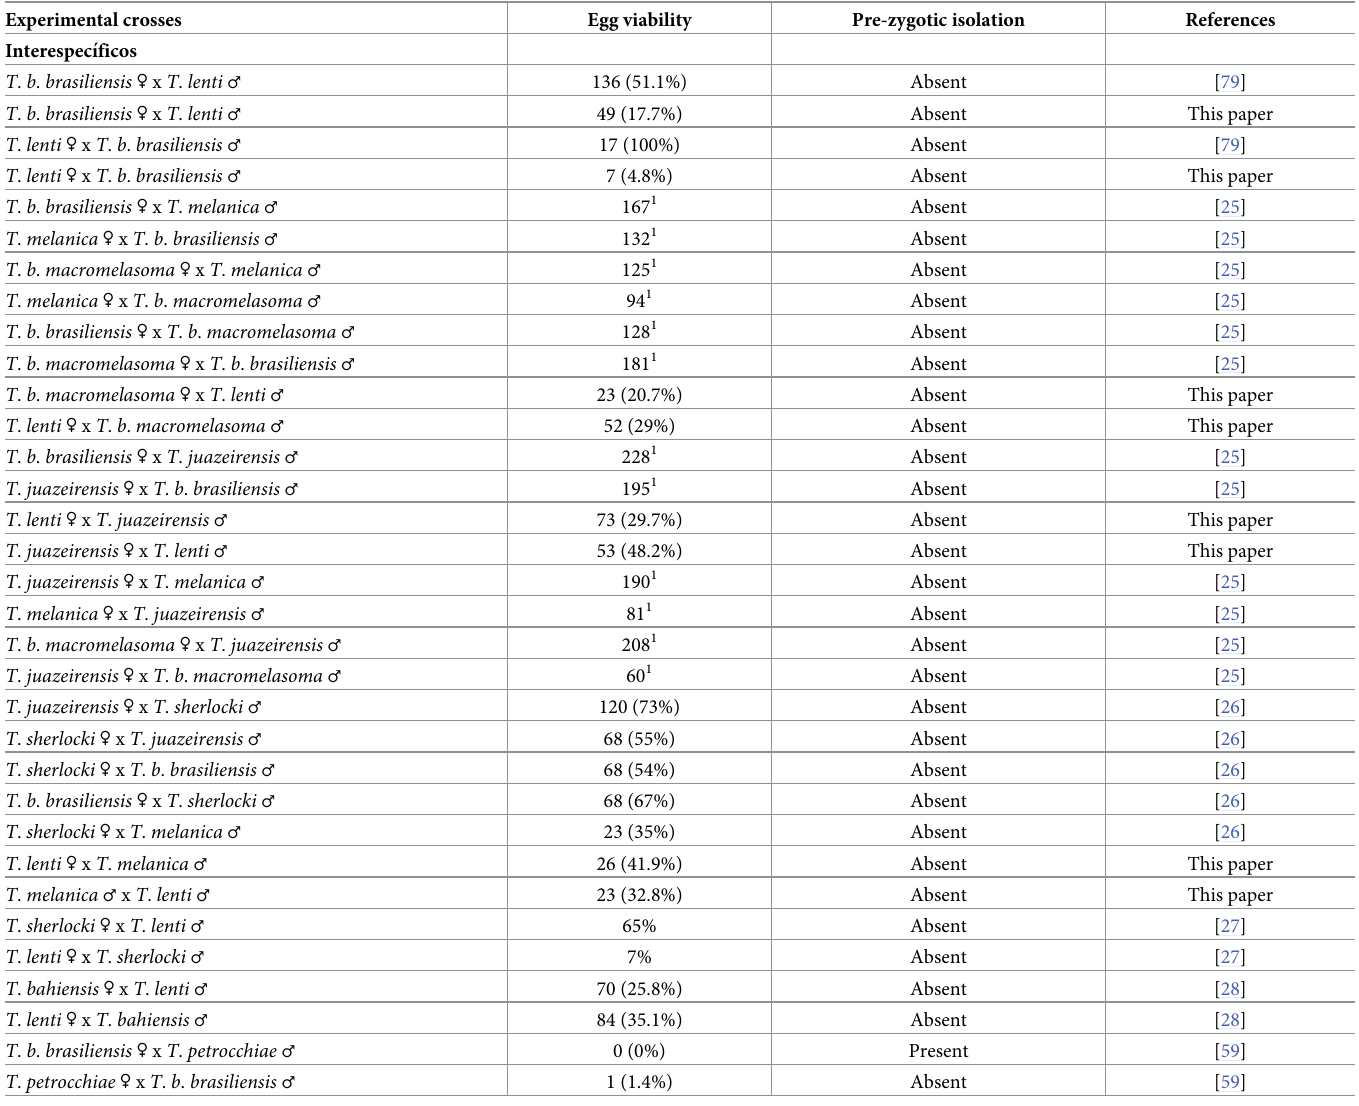
Table 2. Experimental crosses performed between T . brasiliensis species complex.